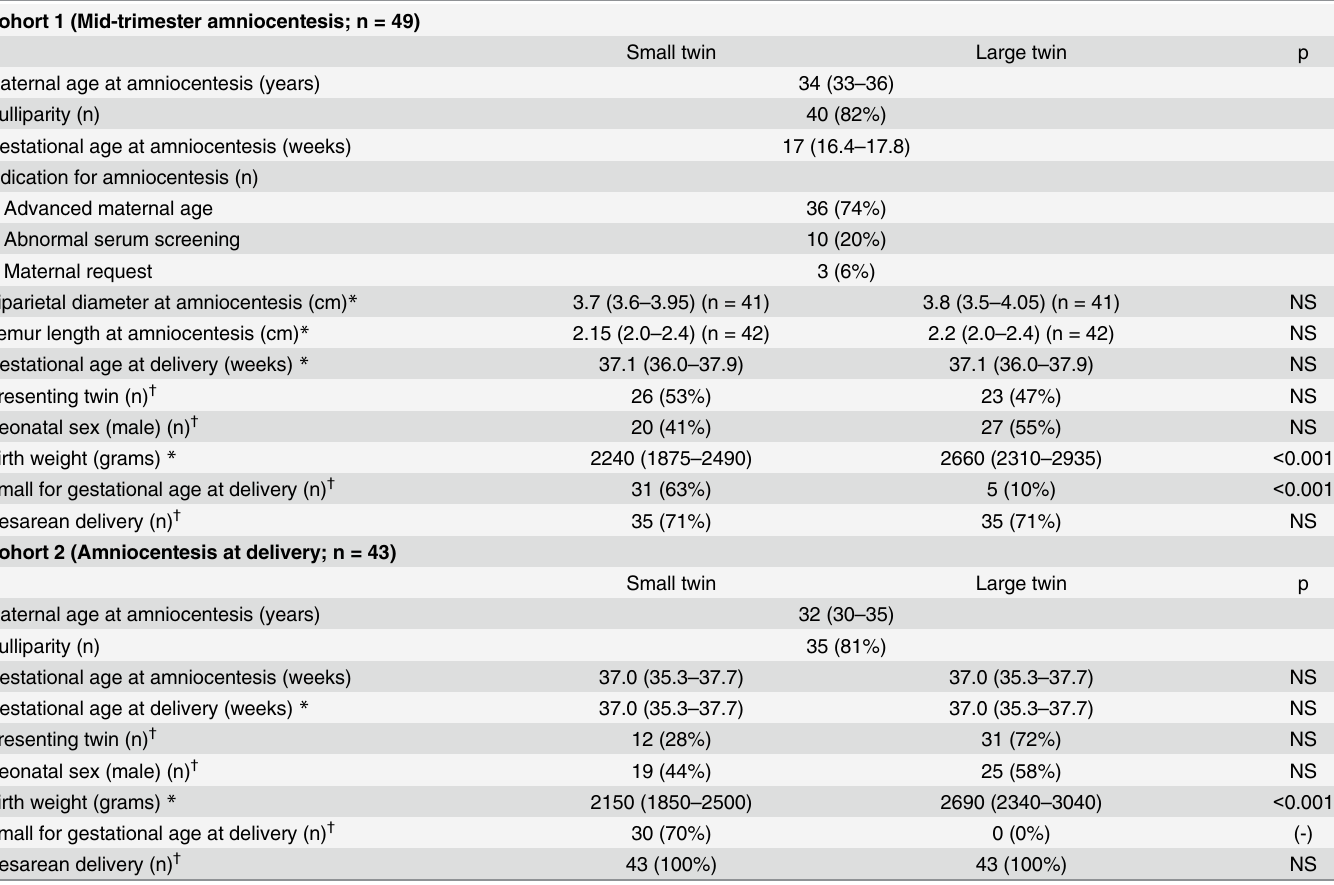
Table 1. Clinical characteristics of the study